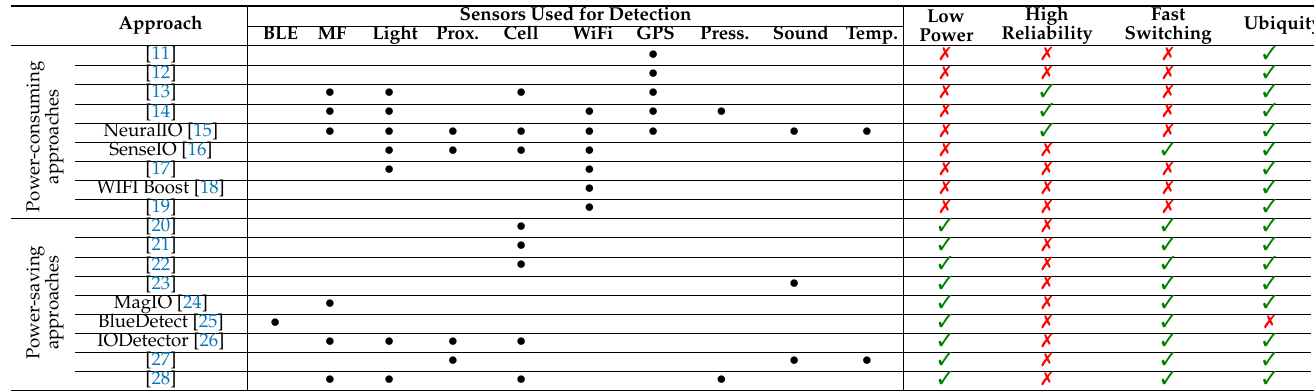
Table 1. The state-of-the-art of indoor-outdoor detection approaches.